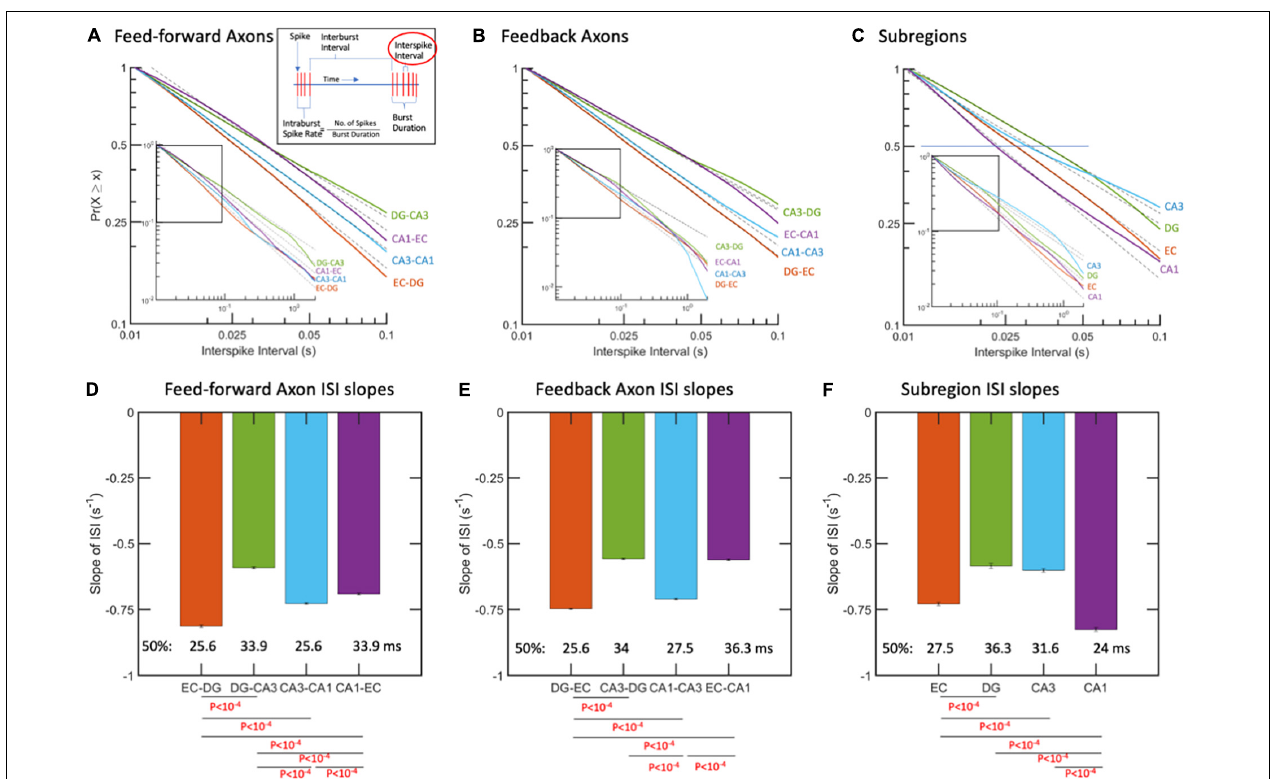
FIGURE 3 | Interspike intervals (ISIs) followed log-log distributions (linear in log-log space). (A) ISIs as complementary cumulative probabilities in feed-forward axons. More spikes at shorter time intervals are from fastest spiking in EC-DG axons. Longer ISIs from slowest spiking axons are in DG-CA3. (B) ISIs in feedback axons. Fastest spiking in axons from DG back to EC. (C) Subregional ISIs are shortest (fastest) in the CA1 subregion. R 2 > 0.99 for all fits. N = 10 arrays. (D) Feed-forward axon ISI slopes of which EC-DG is 27% faster than DG-CA3 and each of the others. The median ISI ( p = 0.5) for EC-DG from A occurred earliest at 25.6 ms for EC-DG. (E) Feedback axon slopes of ISI distributions with DG back to EC significantly faster than the others and shortest median. (F) Subregion neuron ISI slopes with CA1 fastest. P -values calculated using ANCOVA followed by Tukey-HSD. The error bars represent the 95% confidence intervals obtained by